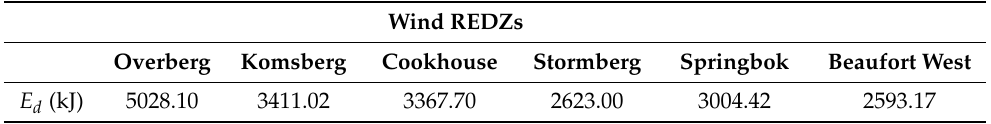
Table 3. Annual energy density for the wind REDZs.